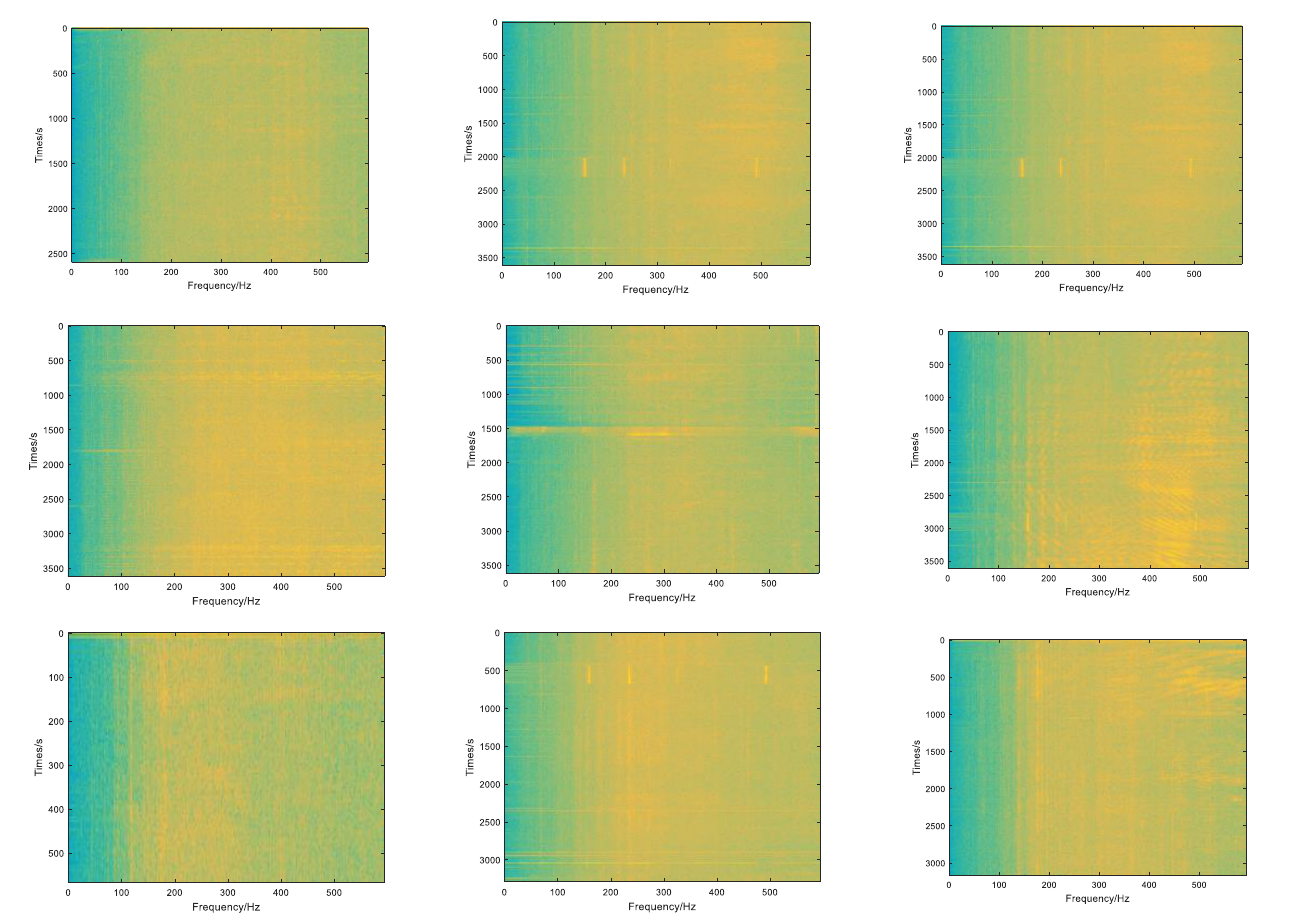
Figure 5. Partial training set of samples for the target detection model.